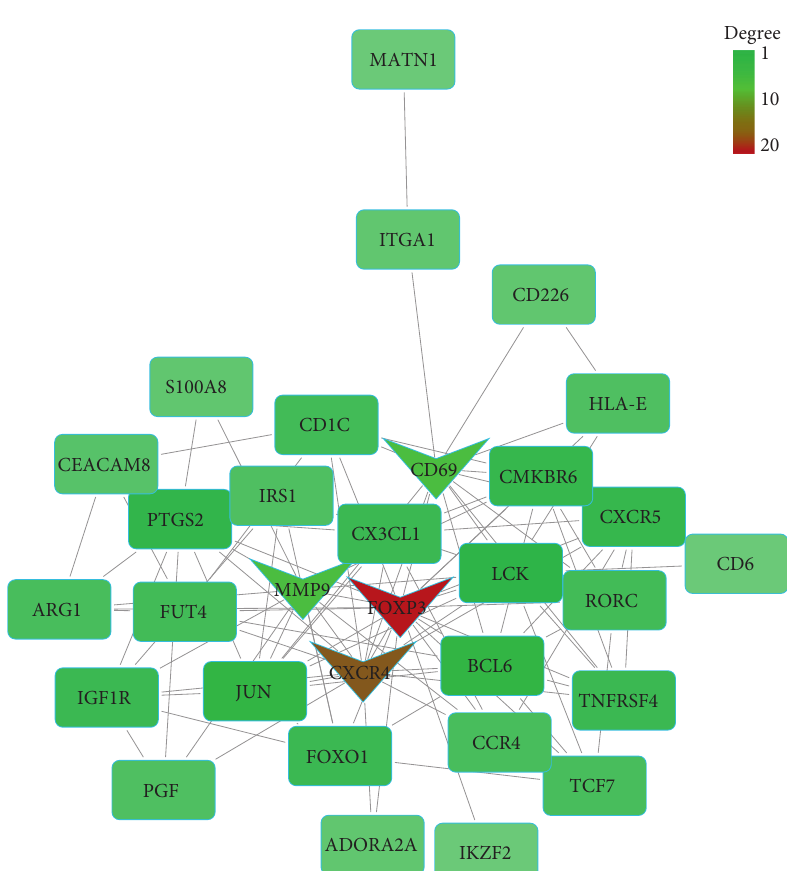
Figure 6: PPI network of downregulated DEGs. The PPI network consists of 31 nodes and 103 edges. Nodes represent protein genes, and edges represent interactions between genes. The darker-colored nodes represent the hub genes, which are FOXP3, CXCR4, MMP9, and